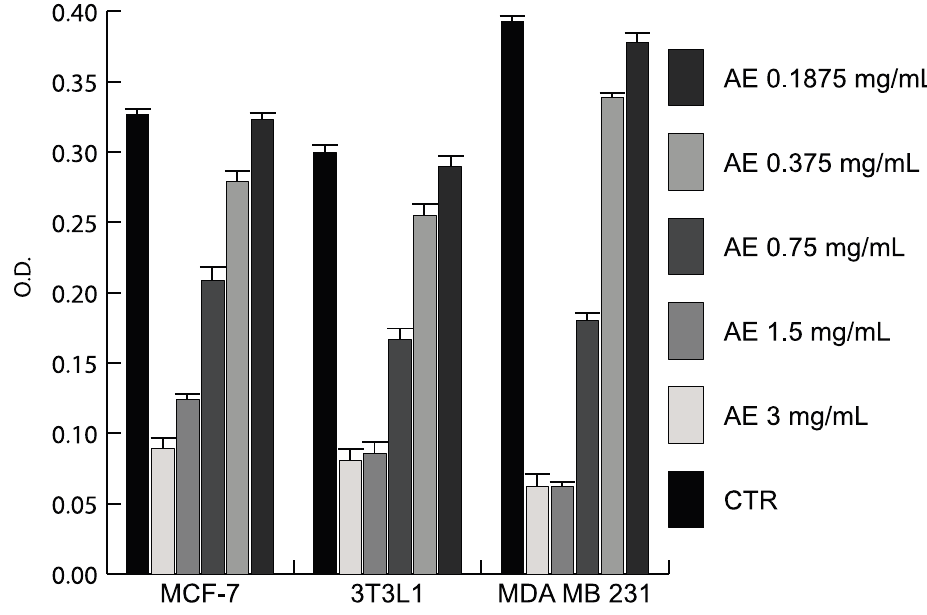
Figure 1. Antiproliferative action of the Xanthoria parietina extract. Proliferation curves by crystal violet assay after 3 days of treatment at different doses in the indicated cell lines. Results are the average of experiments performed in